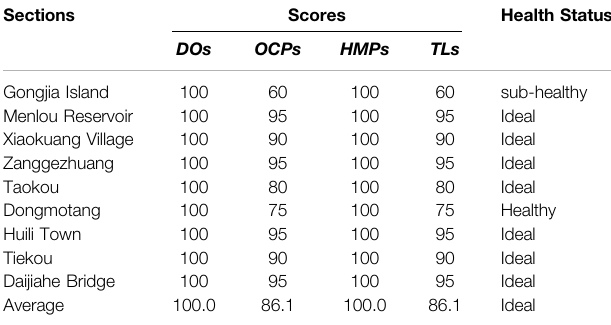
TABLE 9| Results ofgradingand healthassessmentincludingwater temperature variation. Sections